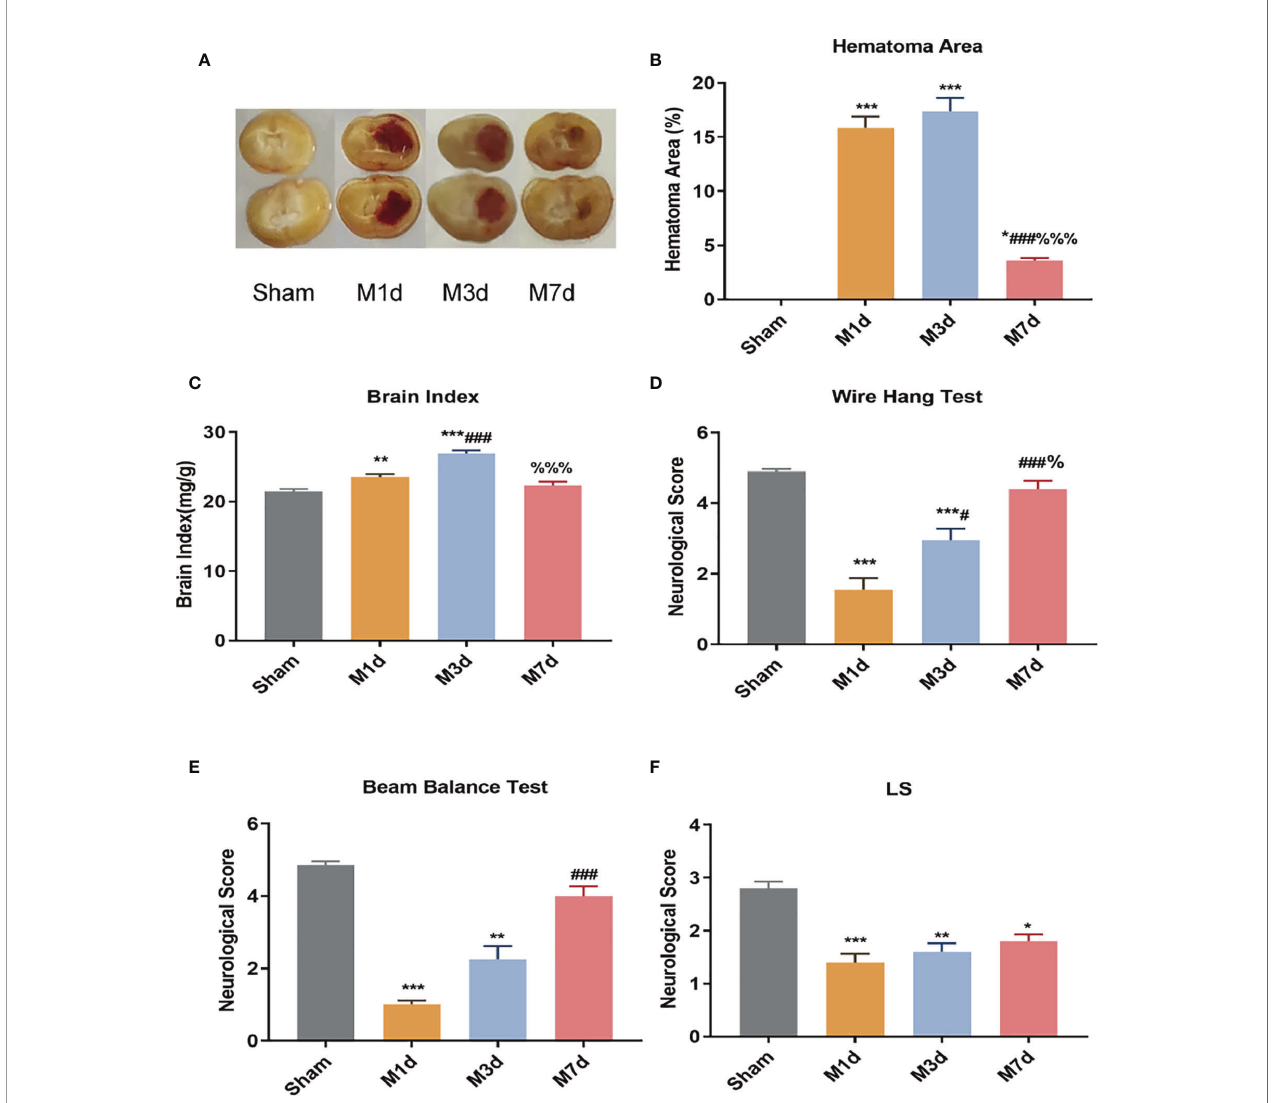
FIGURE 1 | Changes in hematoma area and behavioral scores in the ICH model at different time points. (A) Mouse brain slices: the red in the brain tissue is blood. (B) Cerebral hemorrhage area ratio (n=5). (C) Changes in the brain index in the ICH model (n = 10). ICH neurobehavioral scores at different time points: wire hang test (D) , beam balance test (E) , and with symmetry of limb movement (Ls) test (F) (n = 10). Data are expressed as the mean ± standard deviation. (B, E) One-way ANOVA, Tukey ’ s multiple comparison test; (C, D) Brown-Forsythe test and Welch ’ s ANOVA, Dunnett ’ s T3 multiple comparison test; (E) Kruskal-Wallis ANOVA, Dunnett ’ s T3 multiple comparison test; * P <0.05, ** P <0.01, *** P <0.001 vs. the sham group; # P <0.05, ### P <0.001 vs. the M 1 d group; % P <0.05 vs. , %%% P <0.001 the M 3 d